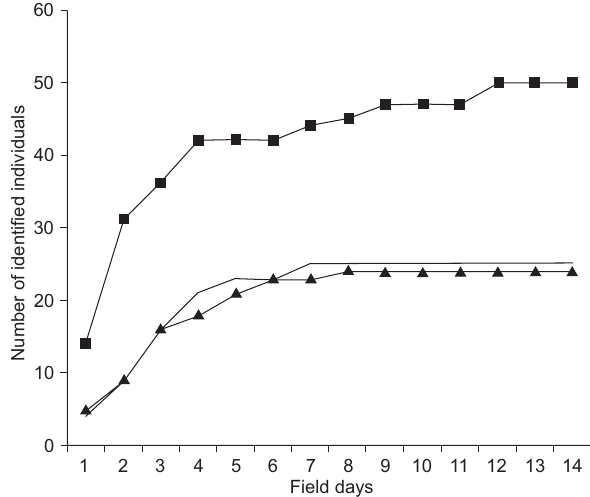
Figure 3. Discovery curves of identified bottlenose dolphins in the Patos Lagoon estuary, Brazil. Line with square markers: dolphins presenting conspicuous long lasting marks on the dorsal fin. Line with triangular markers: dolphins identified by temporary marks in the left side of the dorsal fin, without long-lasting marks. Line free of markers: dolphins identified by temporary marks in the right side of the dorsal fin, without long-lasting